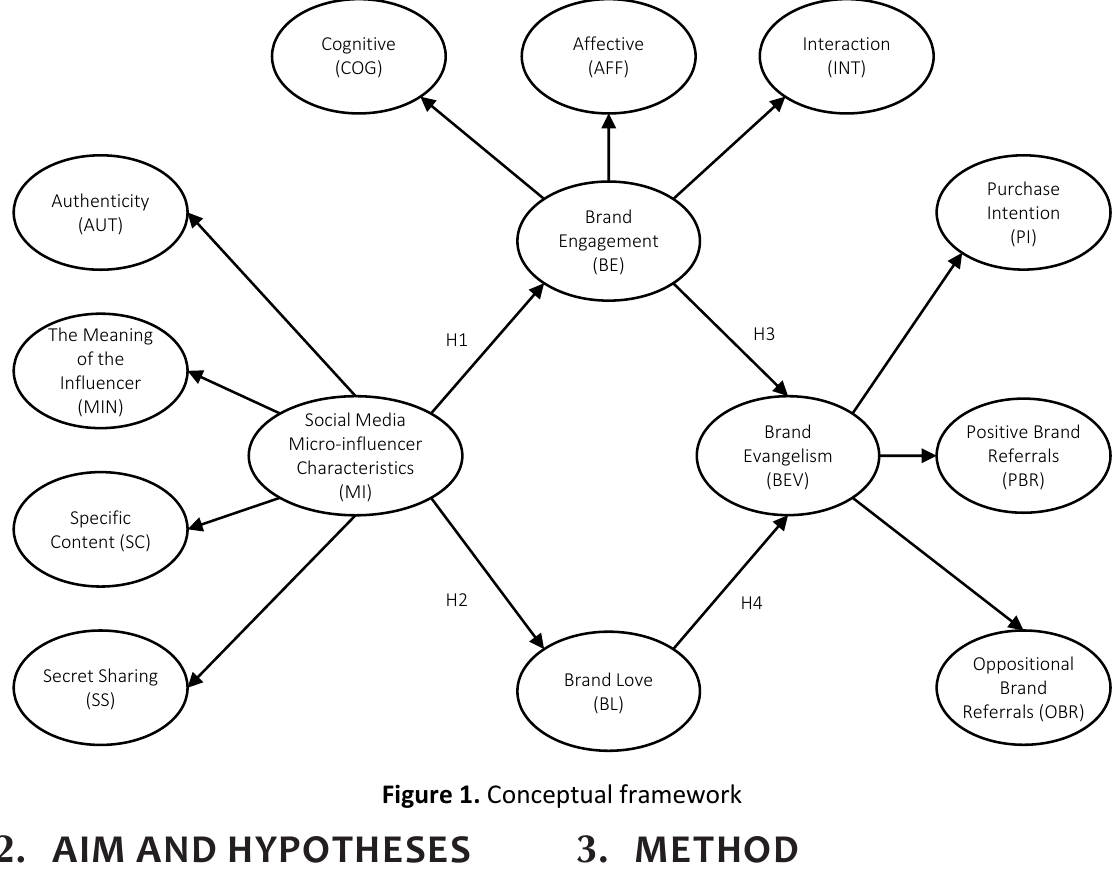
Figure 1. Conceptual